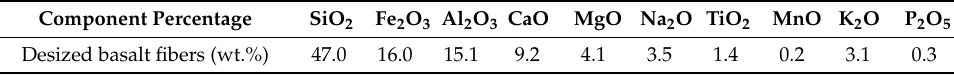
Table 2. The tensile properties of the desized basalt fibers.